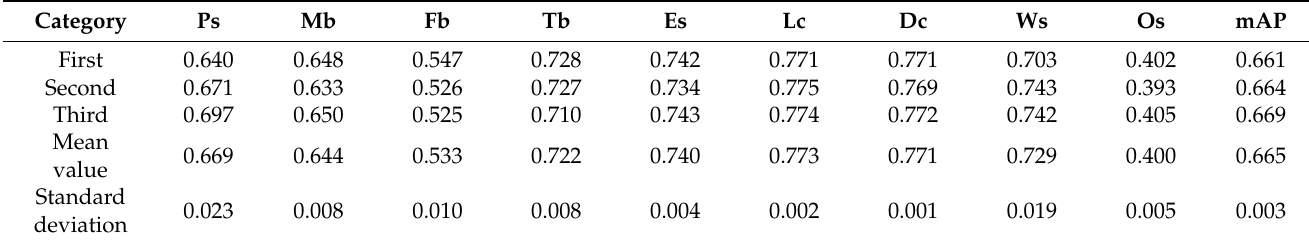
Table 5. AP values of various targets detected in experiment five.